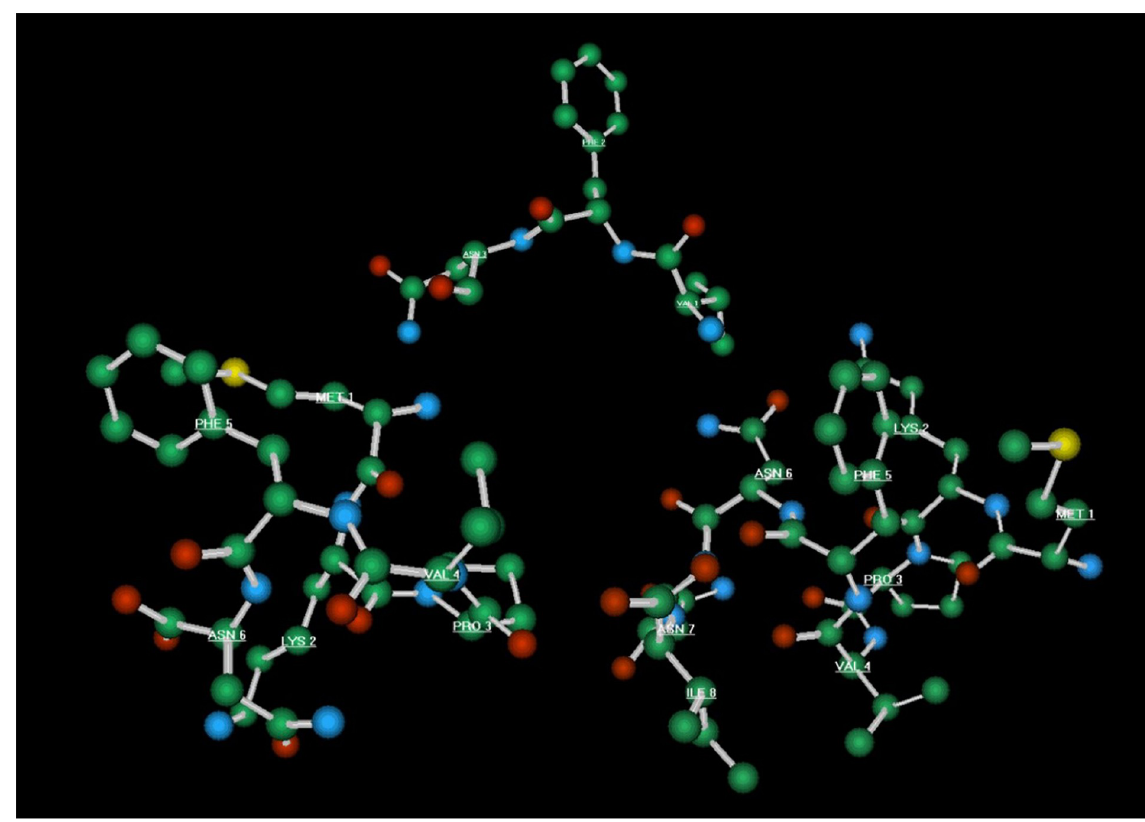
Fig 9. Molecular models. Minimized ball and stick representations in silico of EPL601 (MKPVFN, left) and EPL801 (MKPVFNNI, right), with the tripeptide VFN for reference (top, centre). (Hydrogen atoms deleted for clarity.) In the tri-residue topology analysis of Table 1 this is ‘VFN ↺ ’. The viewing starts at V (VAL 4), moving counter-clockwise to F (PHE 5) then N (ASN 6). The VFN side-chains are in the forward plane in EPL601 and accessible together for binding (+). In EPL801 they are not co-accessible ( − ), as ASN 6 projects rearwards.